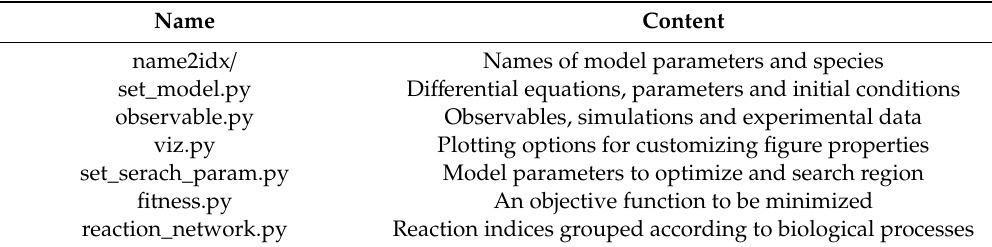
Table 1. A brief description of each model file / folder in